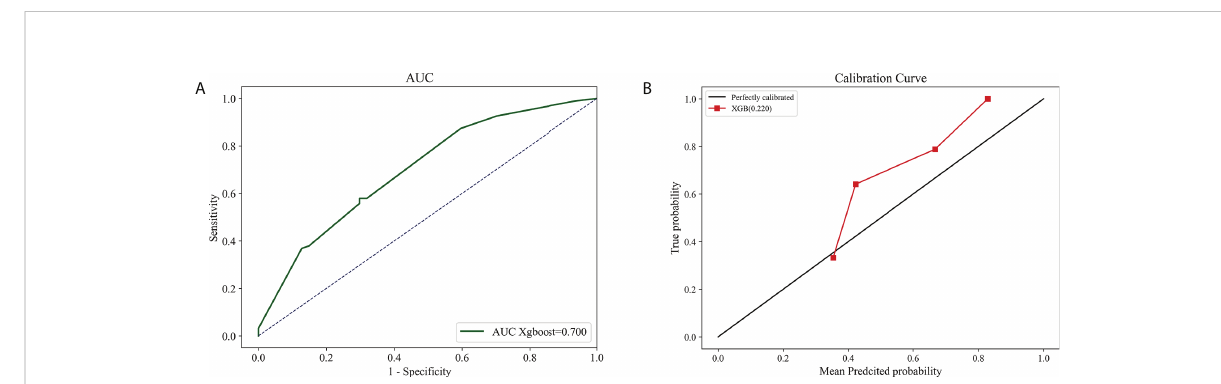
FIGURE 8 The external validation based on Xgboost model. The AUC curve (A) and calibration curve (B) 1n external validation cohort.